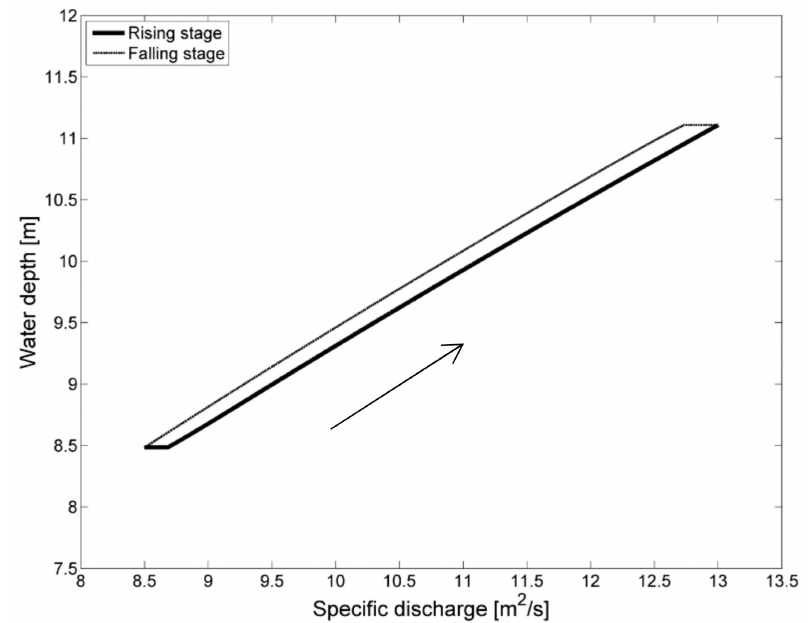
Figure 13. Discharge versus dune height for the rising and falling stages of the hydrograph, using the river scenario. The arrow signifies the direction of development over